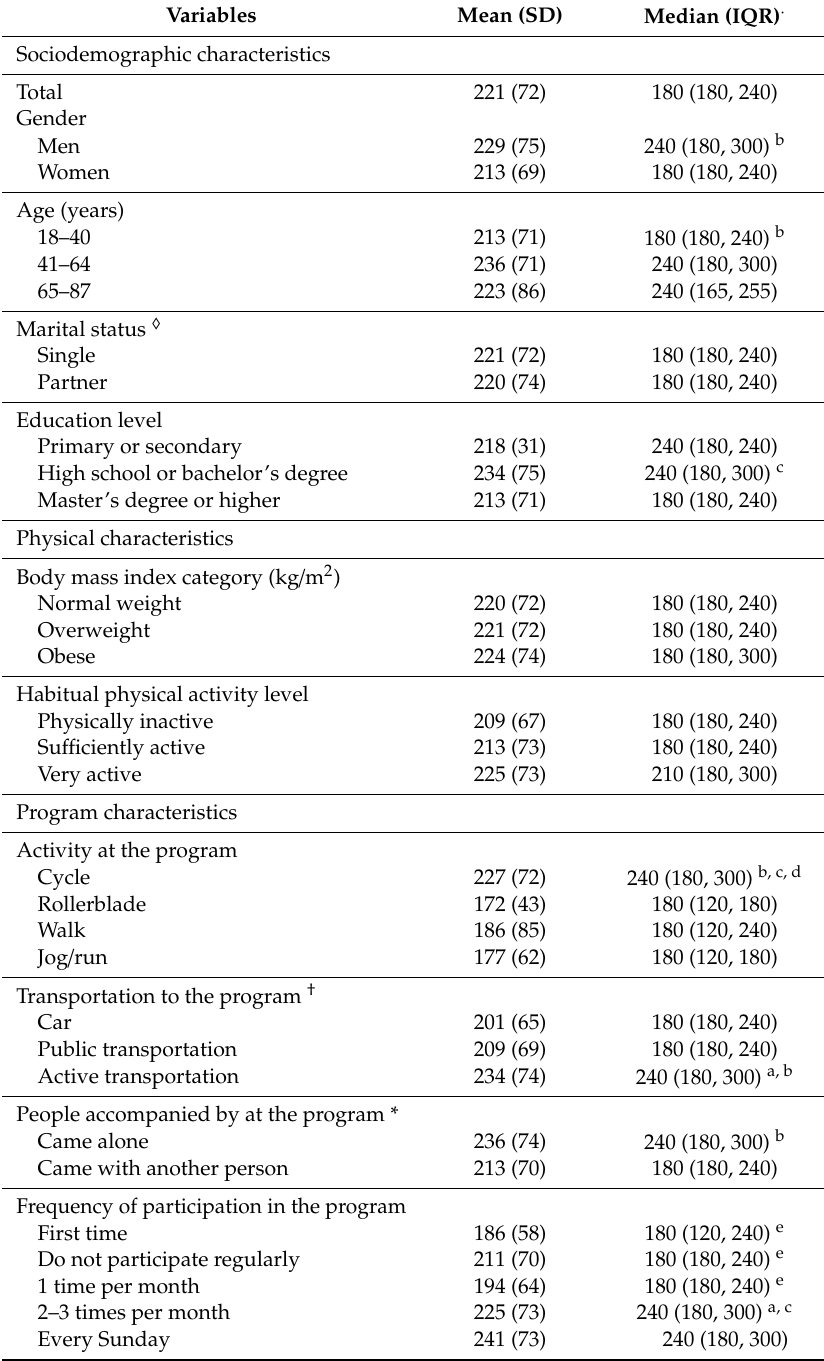
Table 2. Mean and median minutes spent at the program based on sociodemographic, physical, and program characteristics. M é xico City,